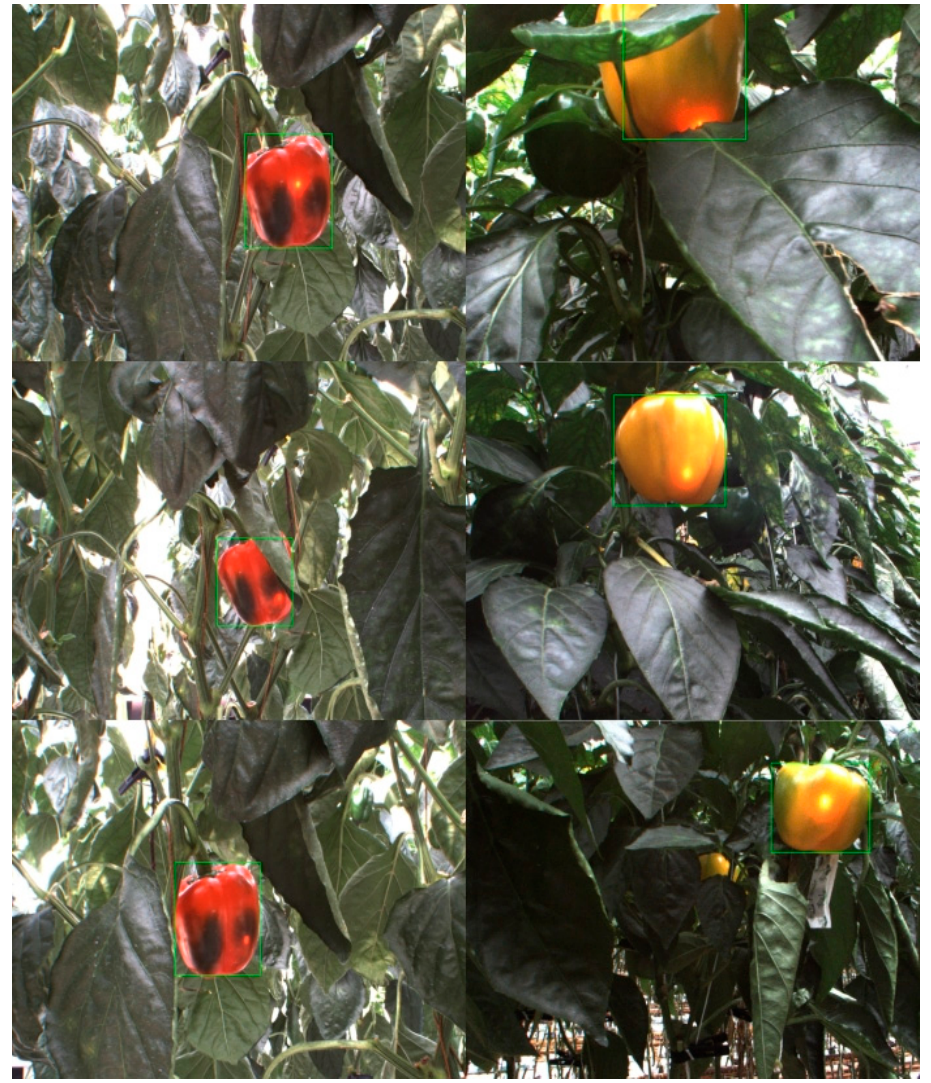
Figure 18. Extracted sweet peppers.